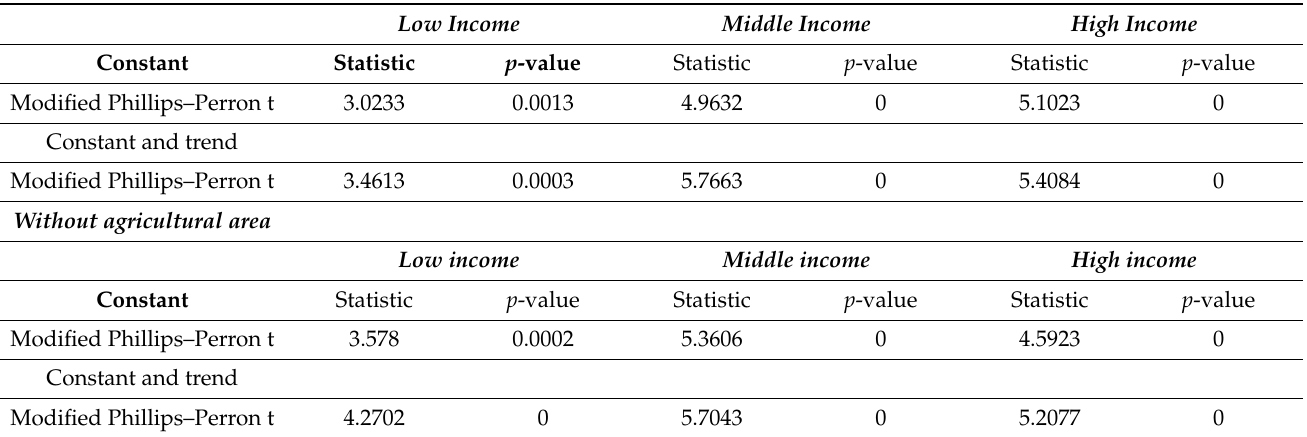
Table A14. Cointegration tests, income country groups.